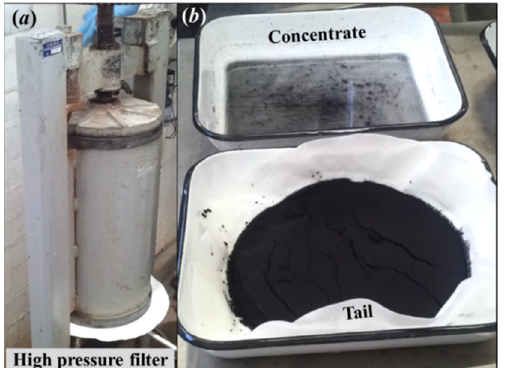
Figure 6. ( a ) A high-pressure filter used to de-water the tail sample; ( b ) after filtration tail sample (bottom right) and flotation concentrate (top right).